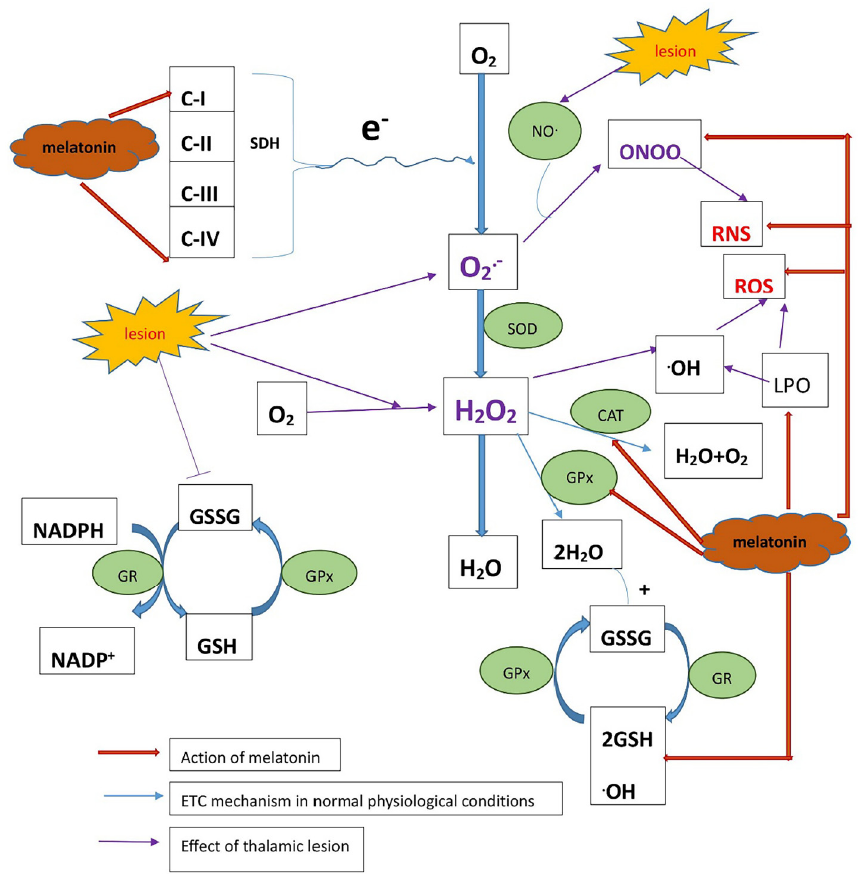
Figure 7. The schematic representation showing an ETC chain reaction in mitochondria in normal physiological conditions, effect of lesion, and effect of exogenous melatonin treatment on ETC. In normal conditions, the electron from the transport chain progresses to form water, but due to the lesion, the oxygen free radical produces nitric oxide radicals, giving rise to RNS. Mitochondrial superoxide dismutase (SOD) neutralizes the highly reactive superoxide radical O 2 –, known as reactive oxygen species (ROS). Under CPSP conditions due to the lesion, ROS and RNS levels increase and melatonin helps to reduce ROS and